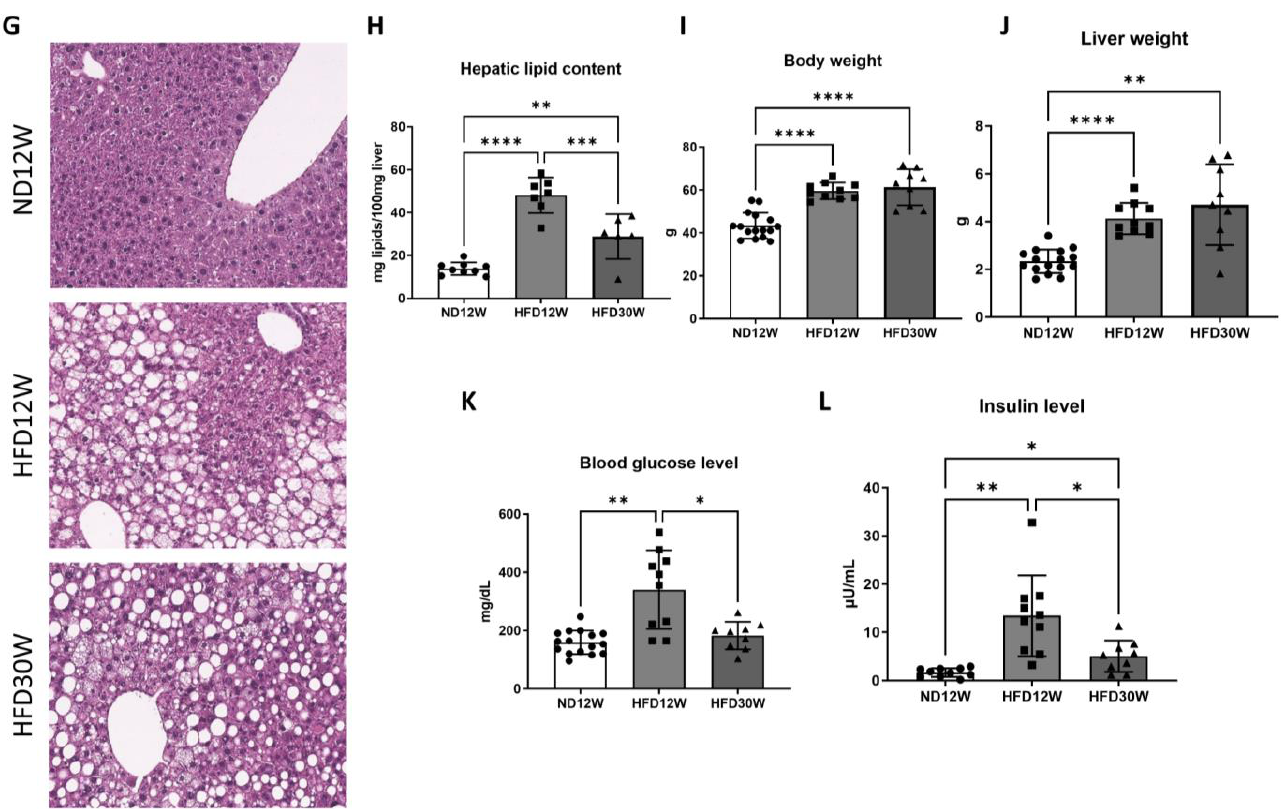
Figure 1. Foz − / − mice develop steatohepatitis, obesity, and insulin resistance. Liver haematoxylin and eosin staining (H&E) ( A ), hepatic lipid content ( B ), body weight ( C ), liver weight ( D ), blood glucose level ( E ), and insulin level ( F ) in mice fed a normal diet (ND4W) or a high fat diet for 4 weeks (HFD4W). Liver haematoxylin and eosin staining (H&E) ( G ), hepatic lipid content ( H ), body weight ( I ), liver weight ( J ), blood glucose level ( K ), and insulin level ( L ) in mice fed a normal diet (ND12W) or a high fat diet for 12 (HFD12W) or 30 weeks (HFD30W). n = 4 – 12/group. * p < 0.05, ** p < 0.01, *** p < 0.001, **** p < 0.0001.